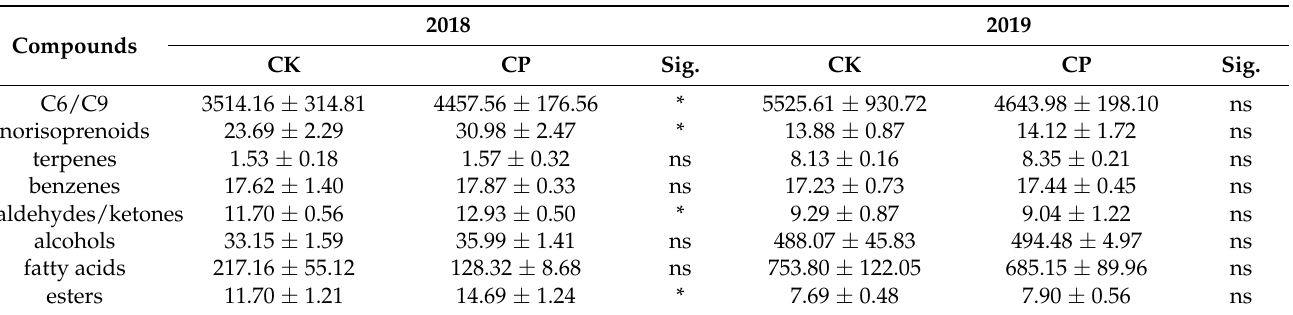
Figure 6. Main differential compounds of clean tillage (CK) and covering purslane (CP) berries. * indicates significant differences between the control and covering purslane ( p < 0.05, t -test), ns, not significant.